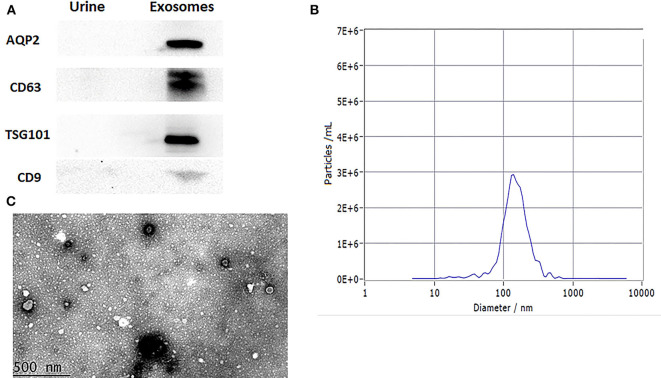
Characterization of urinary exosomes. (A) Western blotting showed the expression of AQP2, CD63, TSG101, and CD9 proteins in exosomes. (B) The size range of the particles. (C) Representative transmission electron micrographs, demonstrating the exosome morphology. Scale bar: 500 nm.